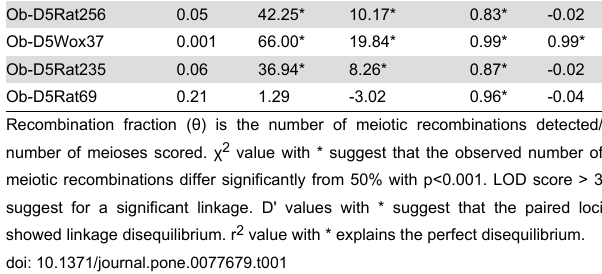
Paired loci θ χ 2